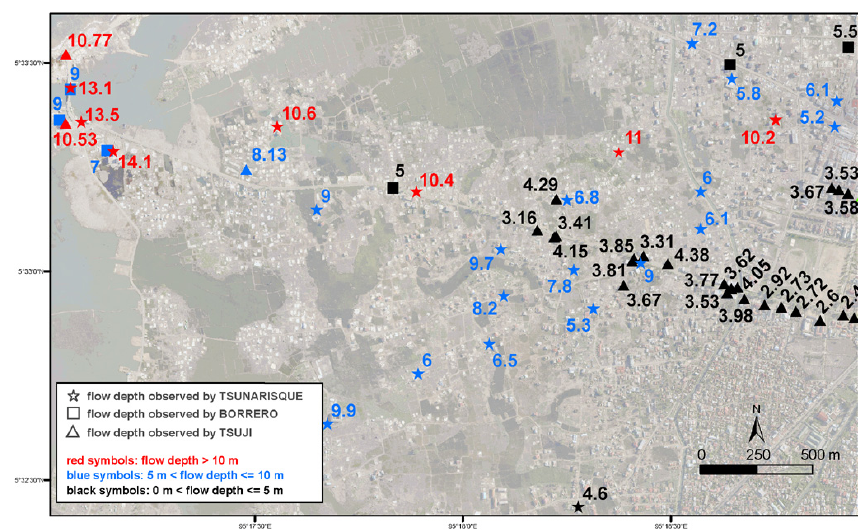
Fig. 1. Comparison between the flow depth data collected in Banda Aceh (Indonesia) by the three different teams presented in Table 1. Colours give the depth ranges (red: flow depth > 10m; blue: 5m < flow depth ≤ 10m; black: flow depth ≤